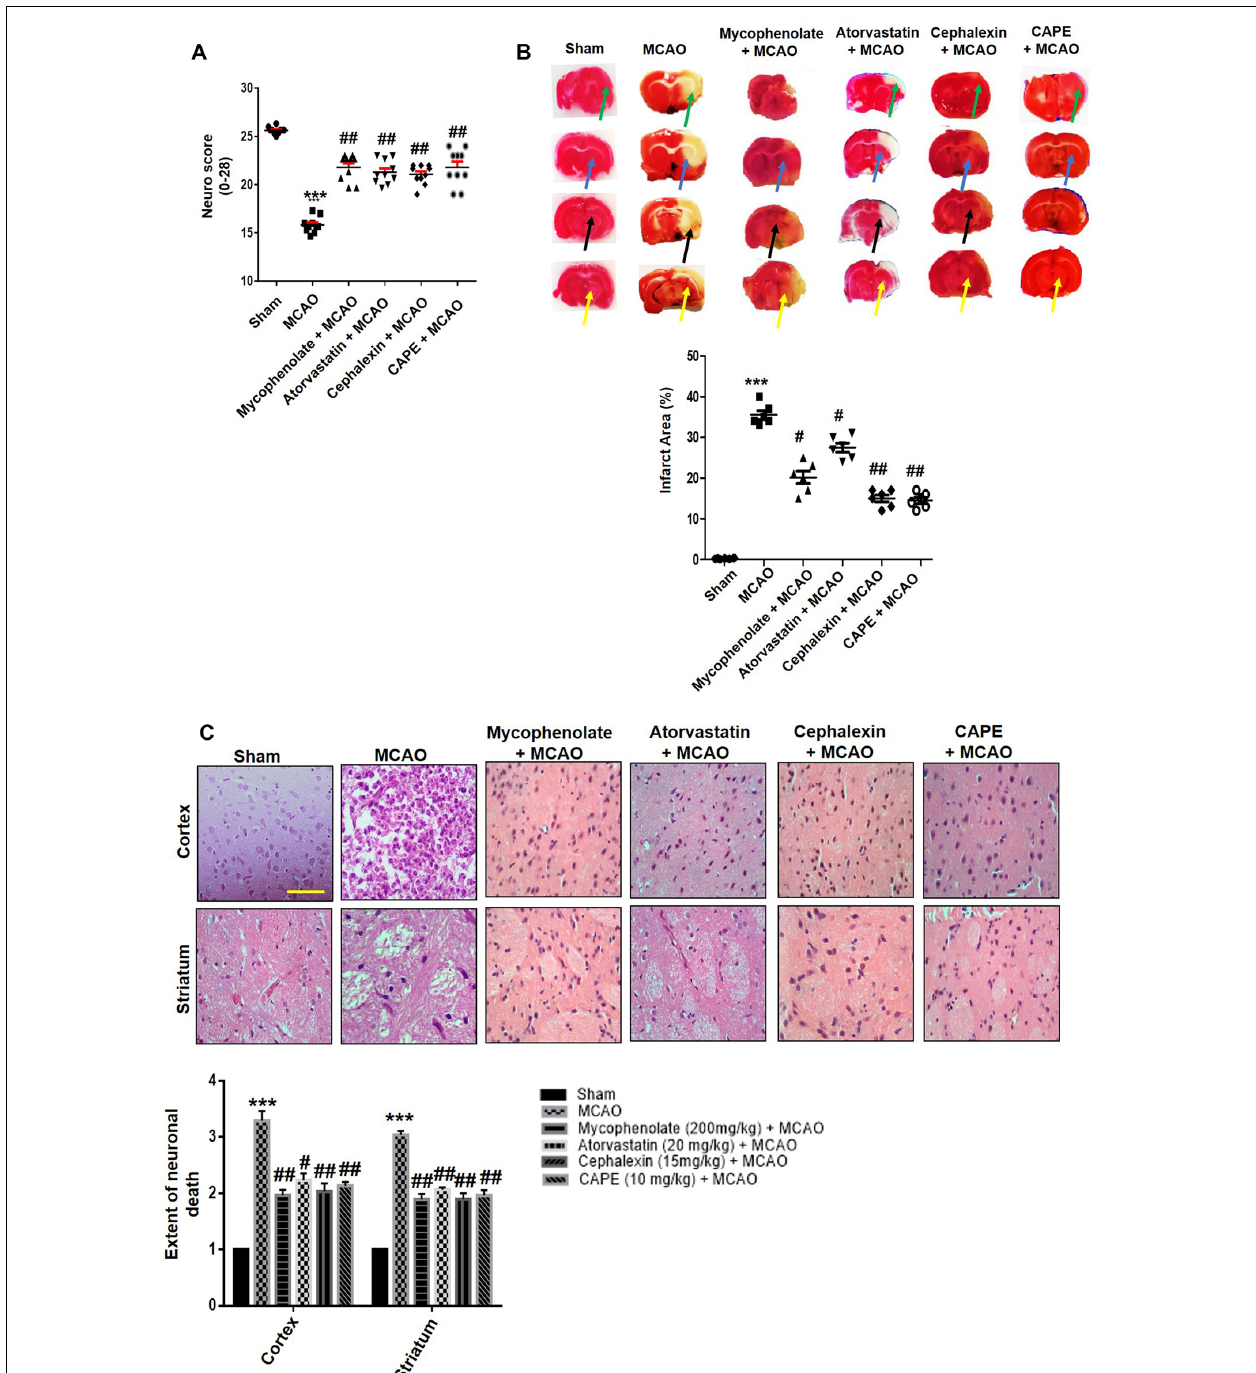
FIGURE 4 | Effect of test drugs on brain infarction and neurodegeneration. (A) 28 points composite scoring. Data are presented as Mean ± SEM, analyzed by one-way ANOVA ( n = 10/group). ***Indicates p < 0.001, and ## represent p < 0.01. Symbols *shows significant difference relative to sham control while # shows significant difference relative to the MCAO group. (B) Brain coronal sections were stained with TTC which distinguishes between ischemic and non-ischemic areas ( n = 5/group). ***Indicates p < 0.001, while symbol ## represent p < 0.01 significant difference and # indicates p < 0.05. The symbol *shows significant difference relative to sham control while # shows significant difference relative to MCAO. The parietal cortex, striatum, hippocampus and thalamus region are respectively shown by green, blue, black, and yellow arrows. (C) Representative photomicrographs of hematoxylin and eosin staining, showing the extent of neuronal injury. Data are presented as Mean ± SEM, analyzed by two-way analysis of variance (ANOVA). scale bar 50 µ m, magnification 40X. Slides were made from TTC sections, fixed